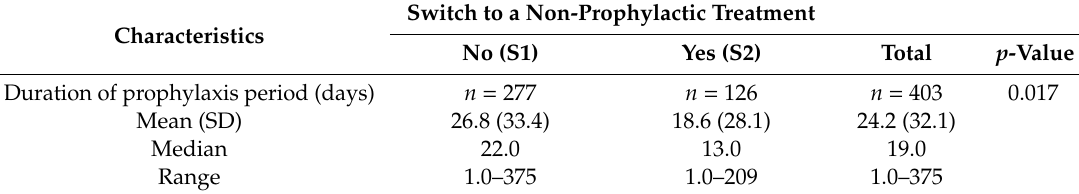
Table 6. Follow ‐ up: patient status 15 days after AFP, neutropenia periods and deaths.